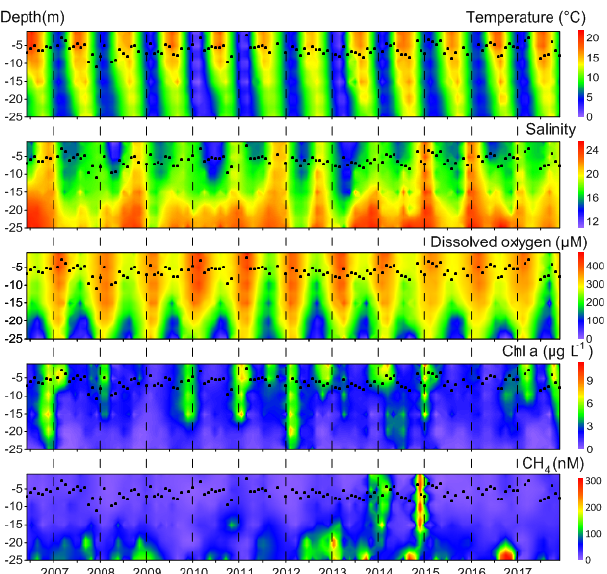
Figure 2. Distributions of temperature, salinity, dissolved O 2 , Chlorophyll a and CH 4 at BE during 2006–2017. Black dots in- dicate the monthly measurements of Secchi depth. To get a bet- ter visualization, the maximum color bar for CH 4 concentration is 300nM, but some of the actual concentrations are higher (for exam- ple, in December 2014 and in autumn 2016).